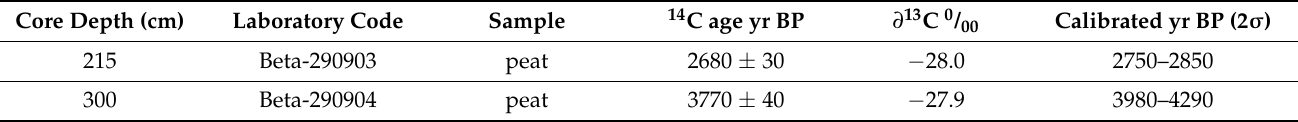
Table 3. Calibrated AMS dates of dated